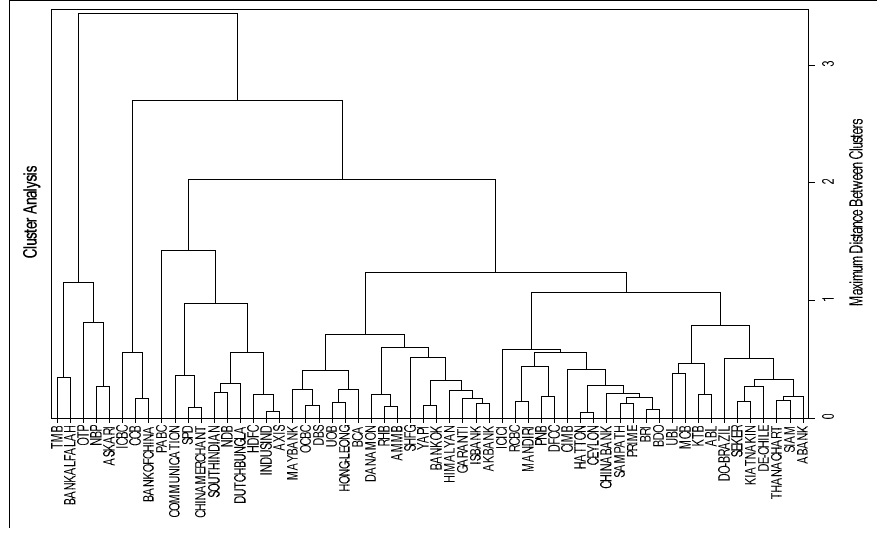
Figure 3. Dendrogram of Hierarchical Clustering.